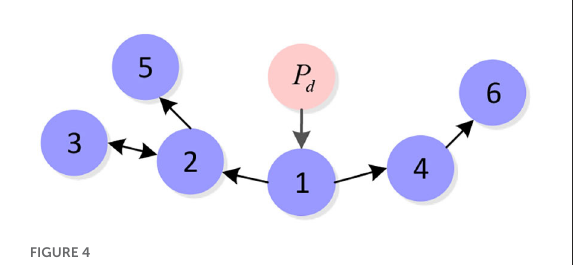
FIGURE4 Communication topology for six plant protection